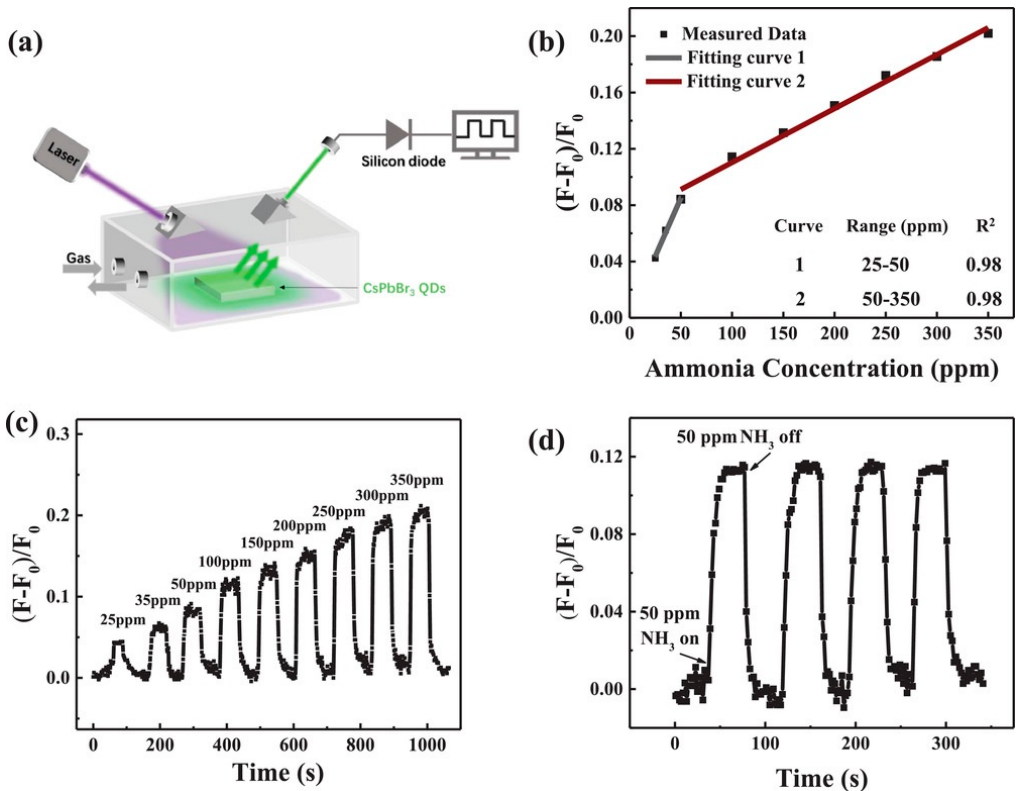
Figure 10. ( a ) Experimental setup for characterization. A fiber is on the right side to the transmission excitation light (365 nm), the pipeline for controlling ammonia flow is on the left side and ( b ) a fitting curve for the sensing response value of PL intensity. The inset is the fitting parameters of the two fitting curves; ( c ) dynamic sensing responses of different NH 3 concentrations (from 25 to 350 ppm) and ( d ) four successive sensing cycles of the CsPbBr 3 QDs sensor (50 ppm; reproduced with the permission from reference [140]).